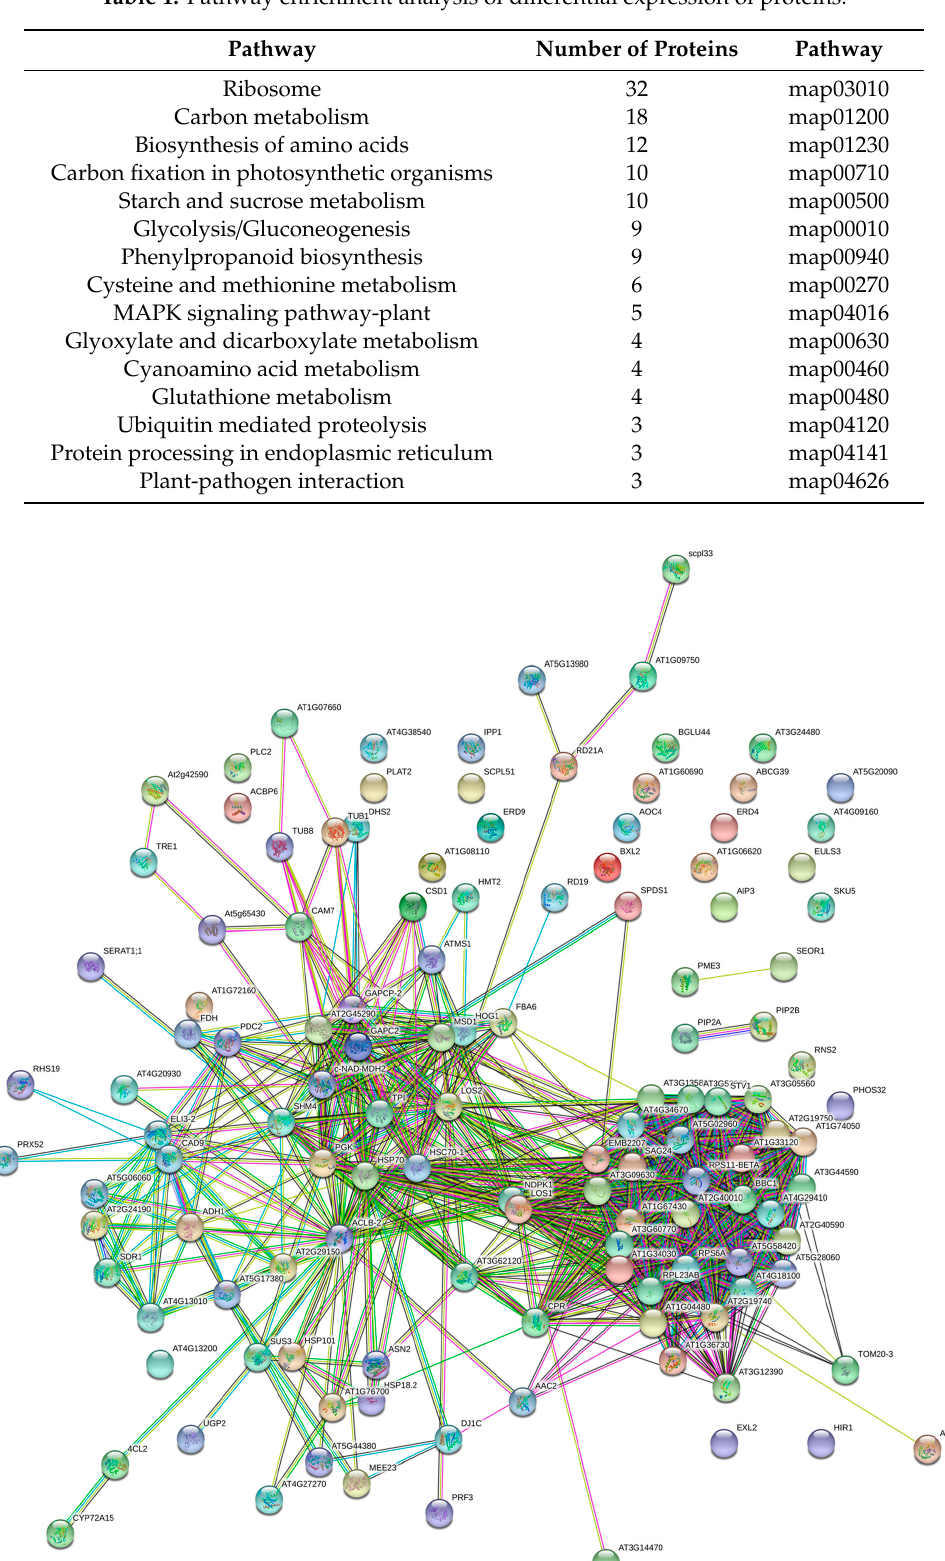
Table 1. Pathway enrichment analysis of di ff erential expression of proteins.